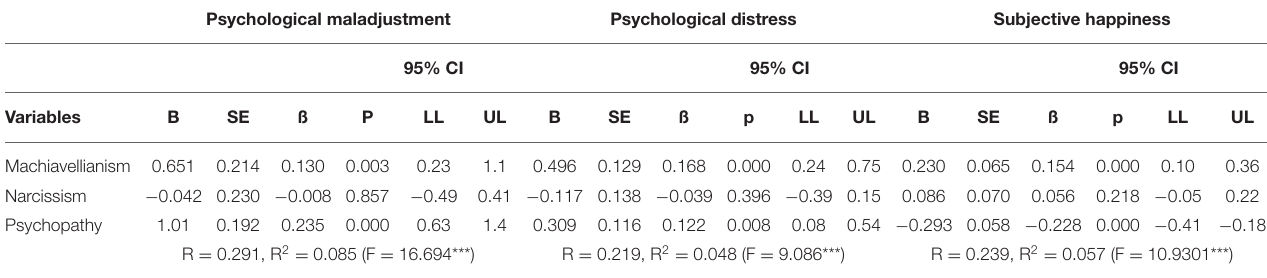
TABLE 4 | Regression coefficients of dark triad traits on psychological maladjustment, psychological distress, and happiness.